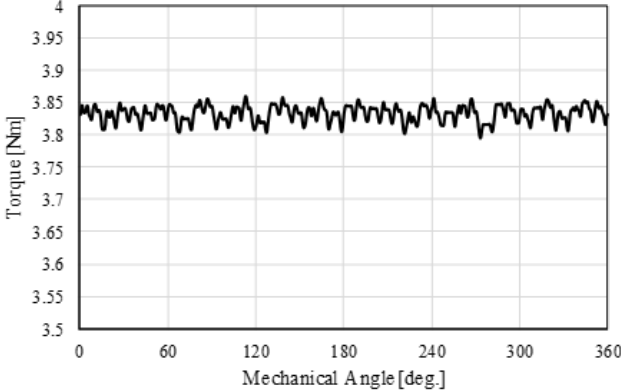
Figure 22. Instantaneous torque waveform.